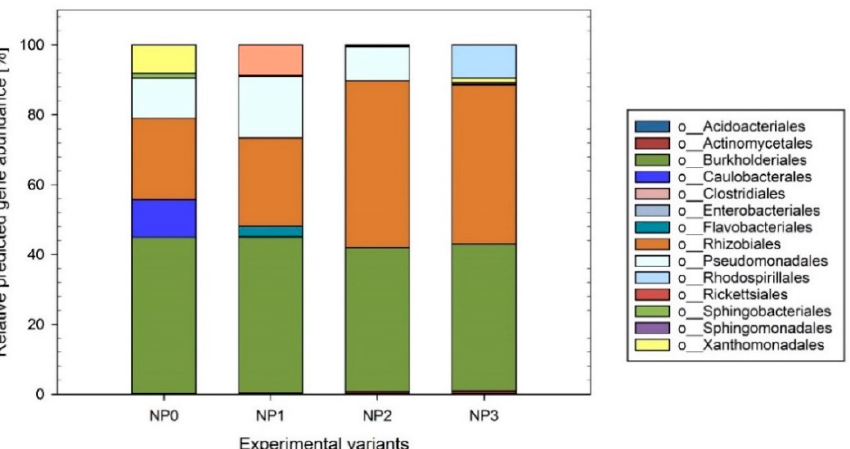
Figure 6. The relative predicted abundance of genes participating in PAH degradation in microbial orders in analyzed experimental variants.